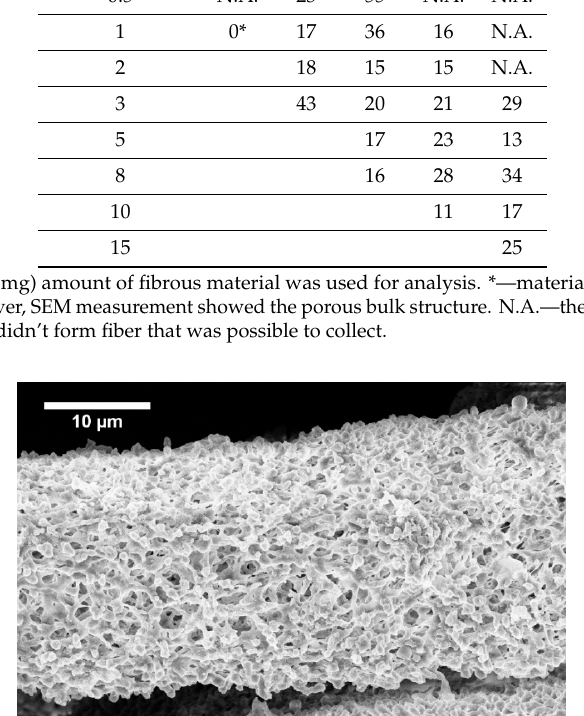
Figure 3. Fiber formed from 1 wt.% solution with 0.5 ml.h − 1 feed rate.